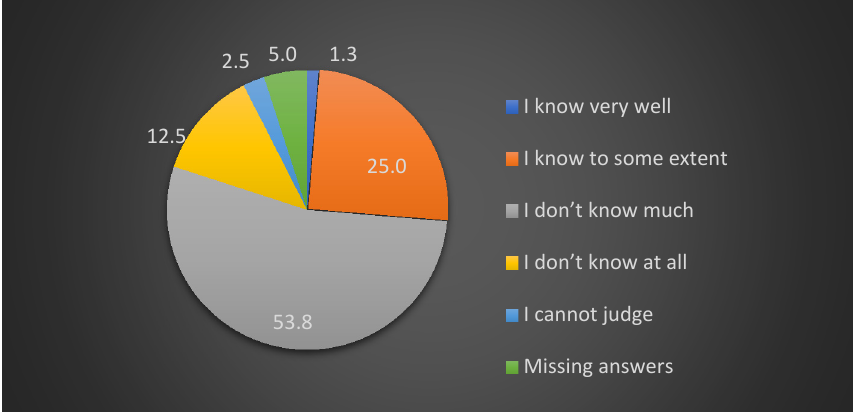
Figure 9. Visitor self appraisal of environmental knowledge from the question: How much do you think you know about the geology, geomorphology, and ecology of North Japan Alps?